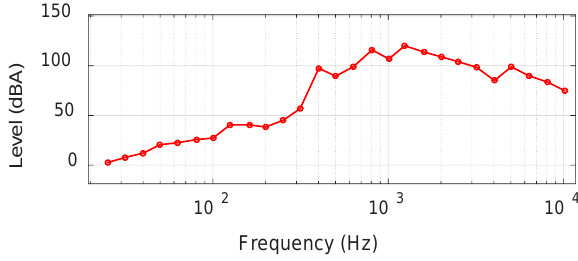
Figure 2. A-weighted sound power level (Lw) spectrum of a typical siren by Howard [40].